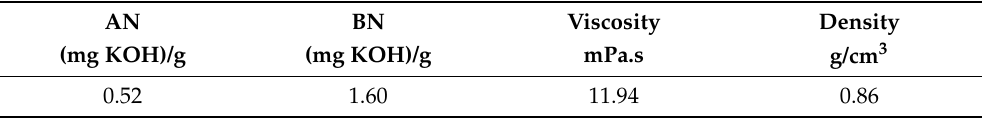
Table 2. The crude oil’s properties.